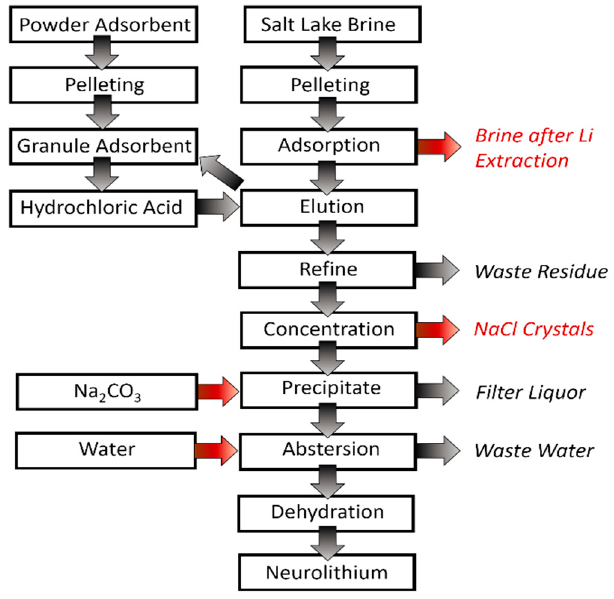
Figure 6. Process flow chart of lithium extraction by adsorption.